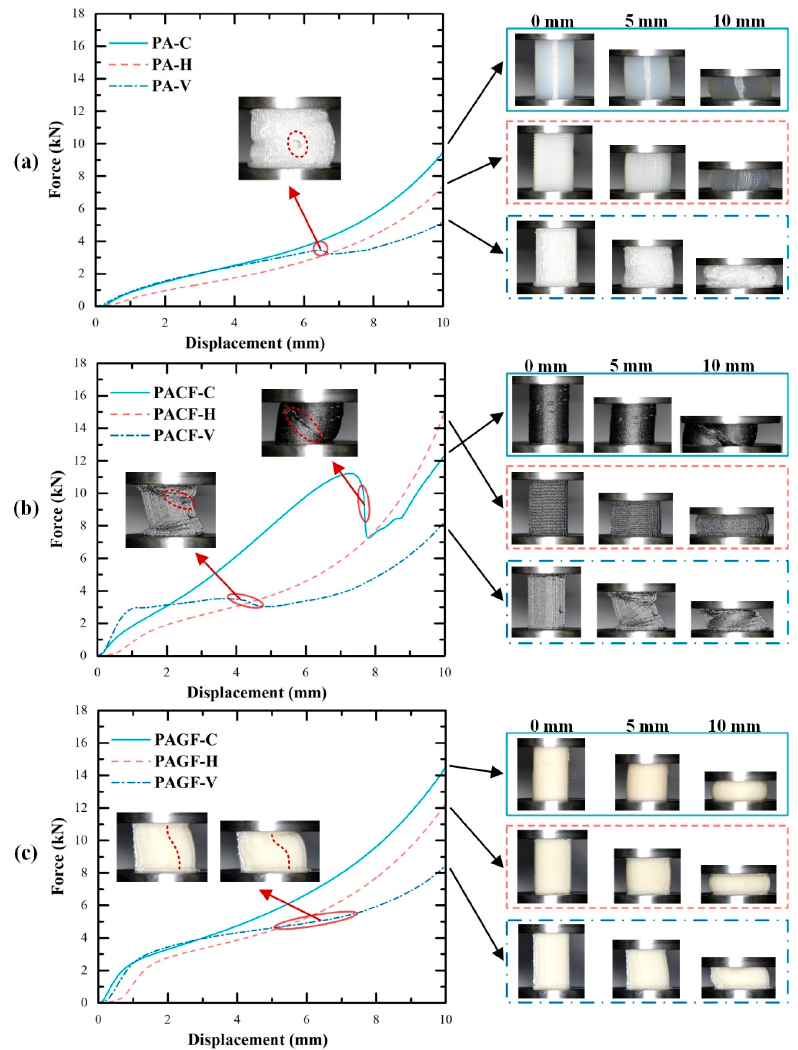
Figure 8. Force responses and corresponding deformation and collapse modes of columns: ( a ) PA; ( b ) PACF; ( c ) PAGF (printed at 240 °C) (red dashed circles and lines drawn in pictures indicate the collapse mode of columns).